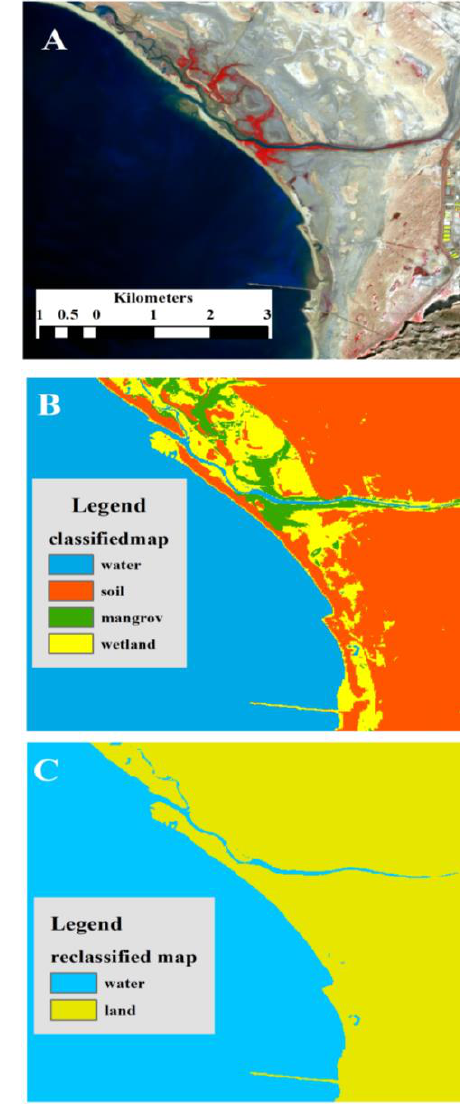
Figure 6 . (A) False color image from 2020/01, (B) map of four classified classes resulting from the image, (C) reclassified map includes water and